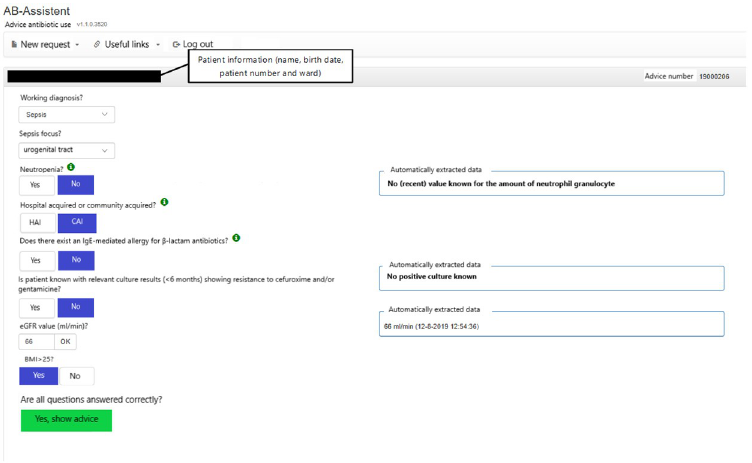
Fig 1. The developed CDSS, which combines relevant electronic patient information with relevant local antibiotic treatment